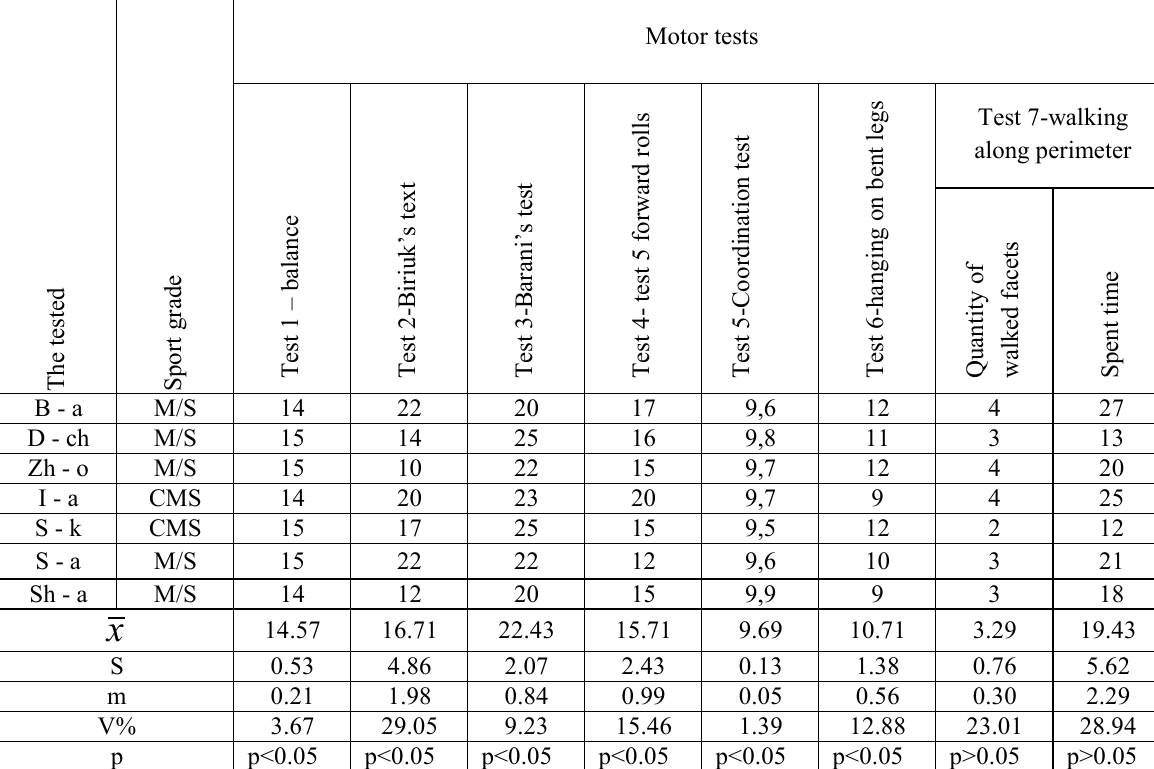
Final indicators of static-dynamic and static –kinetic balance of first year girl students of NUPESU, who specialize in calisthenics